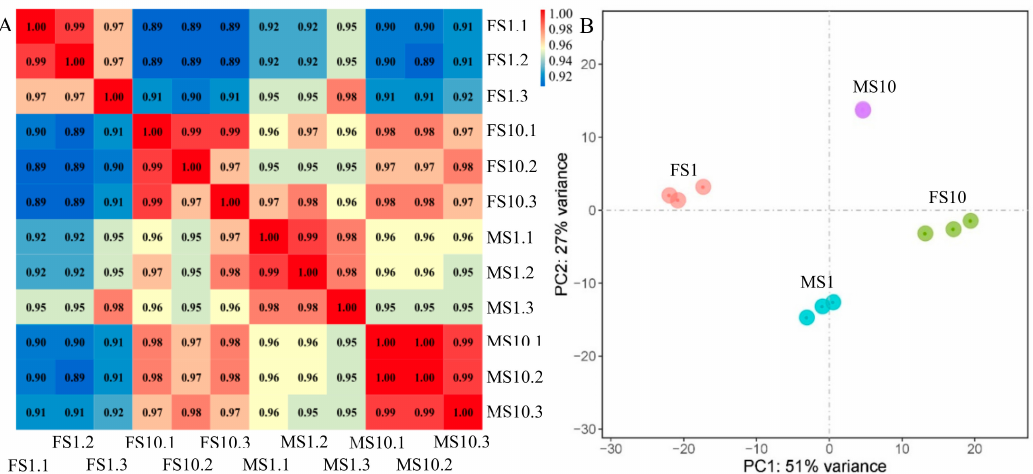
Figure 2. Correlation analysis and principal component analysis of samples. ( A ) Correlation analysis of gene expression between samples. Comparisons of gene expression between replicates on the x-axis and those on the y-axis. The correlation coefficients between replicate samples were approximately 1. The correlation coefficient was show as a color value (blue: less similar, and red: more similar). ( B ) Principal component analysis plot of RNA sequencing (RNA-seq) data in samples. Three biological replicates for each sample type were clustered together. Blue plots indicated samples of ‘9–6’ at one-true-leaf stage (LS1) (MS1), purple plots indicated samples of ‘9–6’ at 10-leaf stage (LS10) (MS10), pink plots indicated samples of ‘2013–12’ at LS1 (FS1), and green plots indicated samples of ‘2013–12’ at LS10